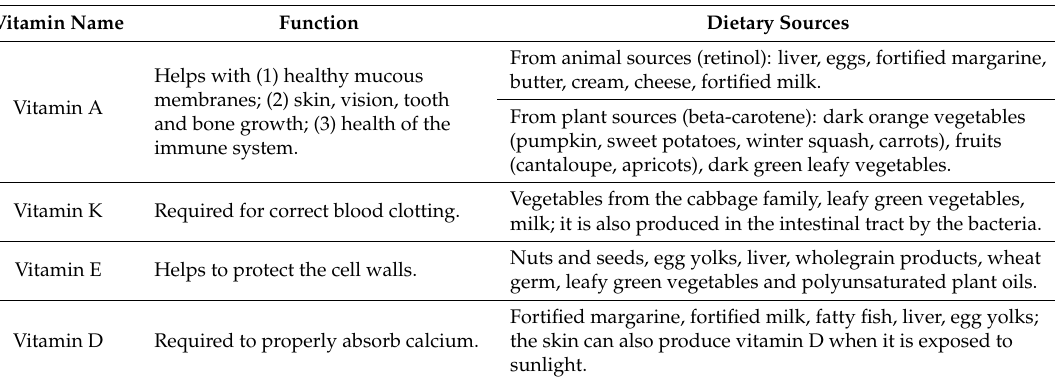
Table 1. List of fat-soluble vitamins [13].